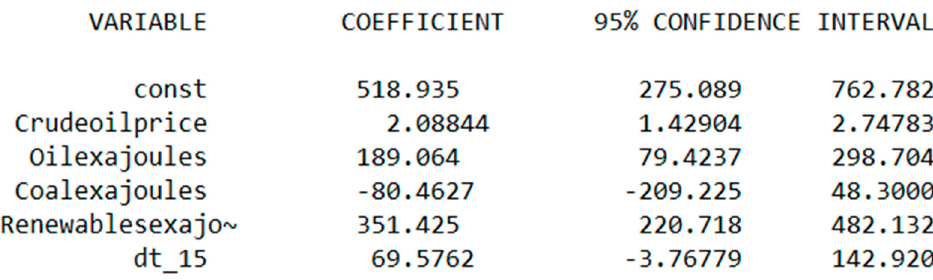
Figure 23. Con fi dence interval for the coe ffi cients.